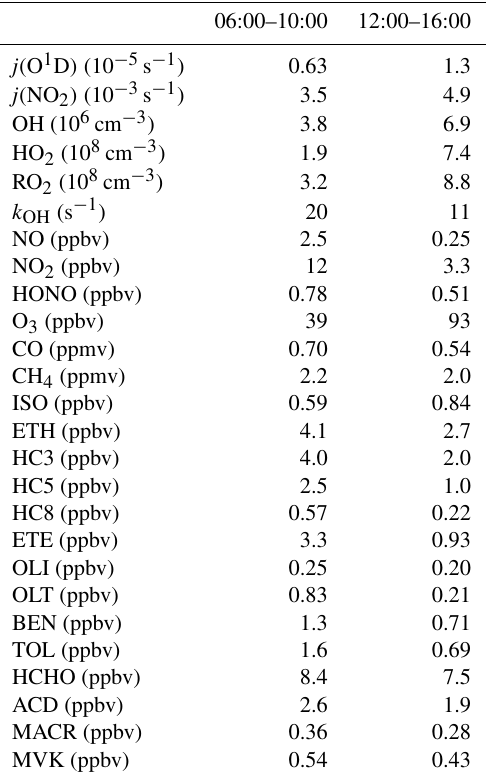
Table 5. Median values of measured species for morning and after- noon hours. Time is indicated in CST.